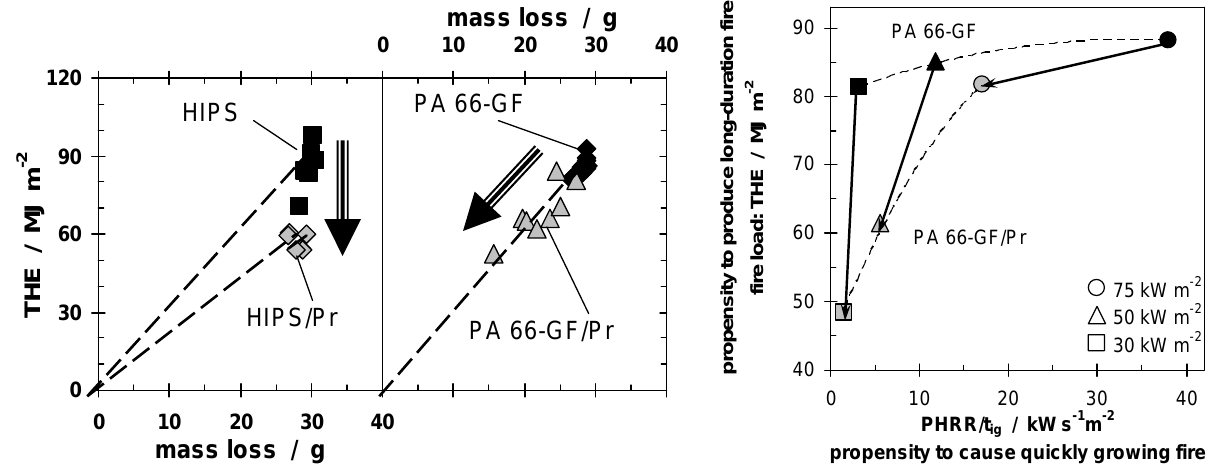
Figure 9. THE plotted against mass loss for HIPS, HIPS/Pr, PA 66-GF, and PA 66-GF/Pr, illustrating the flame inhibition of Pr in HIPS and the charring in PA 66-GF (on left). Fire behavior assessment (right), for PA 66-GF and PA 66-GF/Pr, for different fire scenarios (different heat fluxes). The fire load (THE) and a fire growth index (PHRR/t two most important fire risks, are plotted on the same